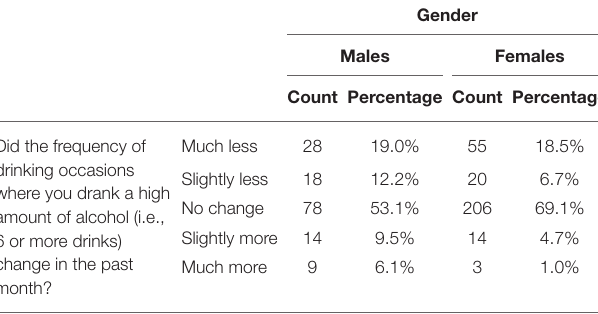
TABLE 3 | Distribution of answers: excessive drinking.